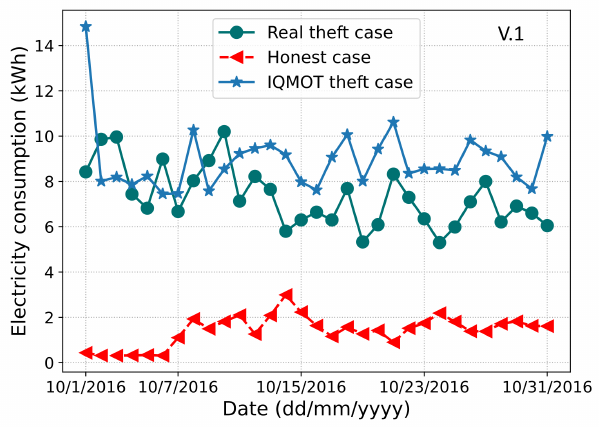
Figure 2. Example of IQMOT0based sample generation of October 2016.